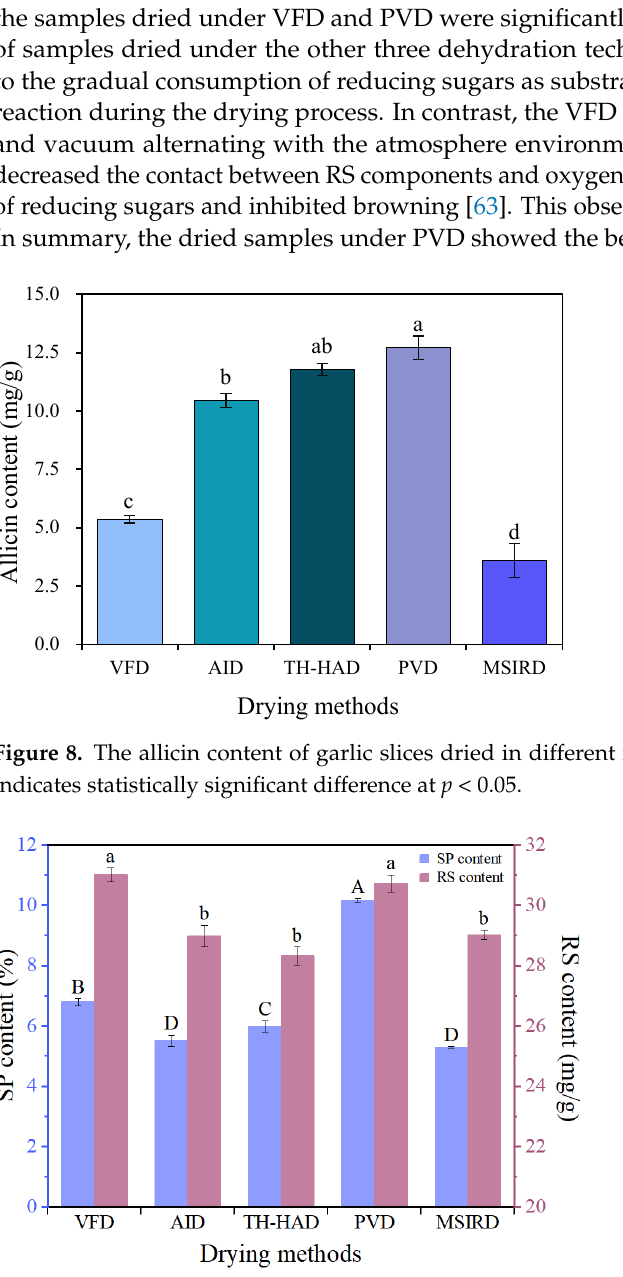
Figure 9. The soluble pectin (SP) and reducing sugar (RS) content in garlic slices dried using different methods. For SP and RS content, the different letters (A–D, a,b) indicate statistically significant difference at p < 0.05, respectively.